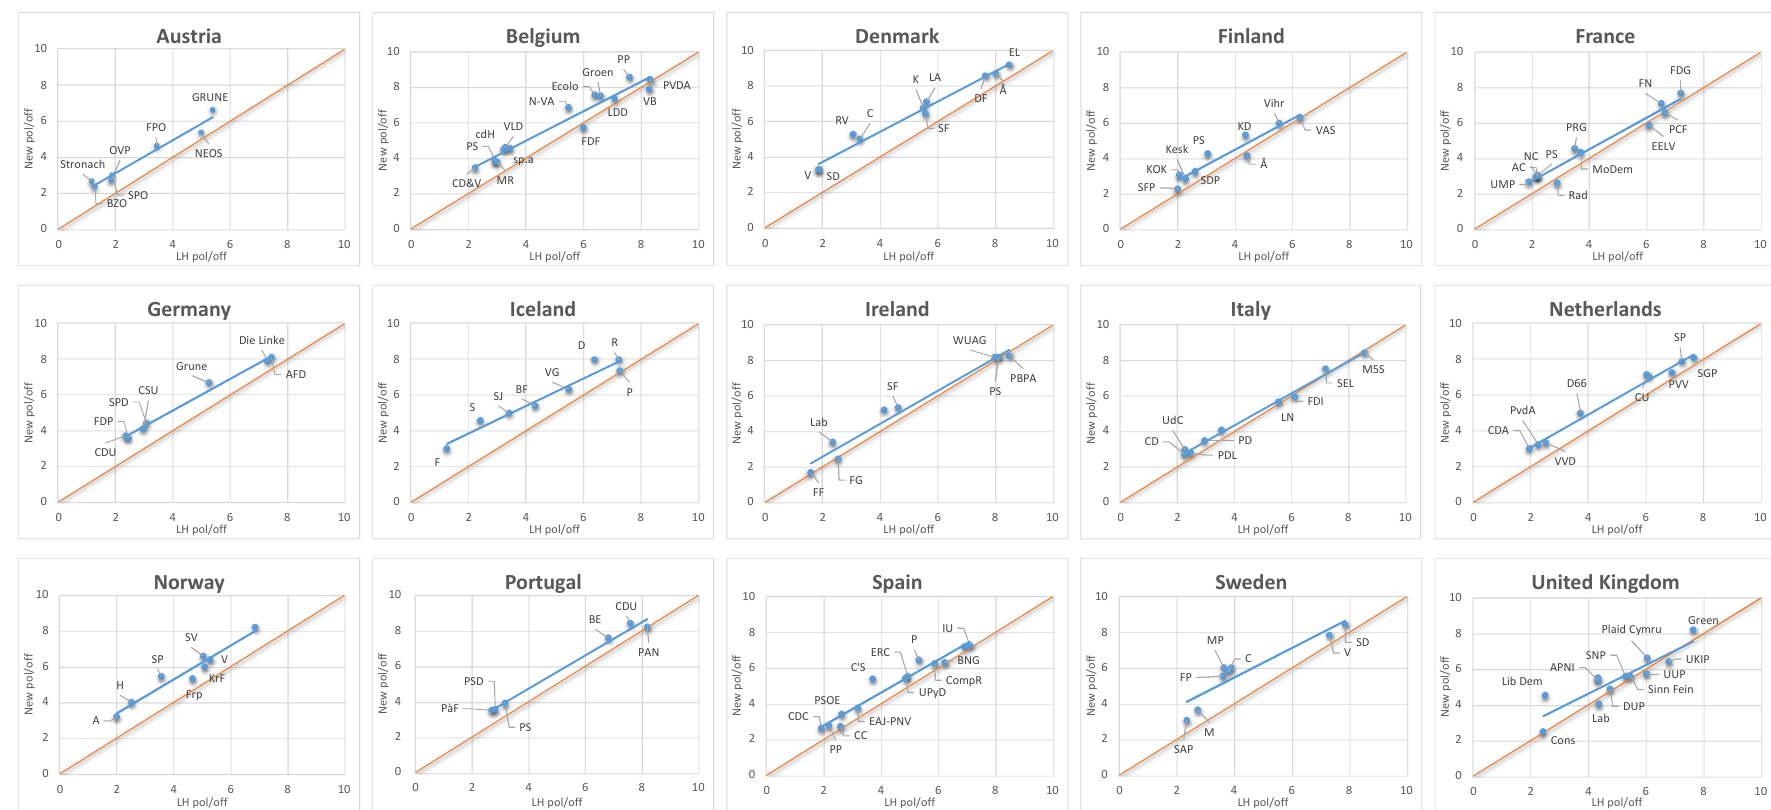
Figure 4. Parties’ policy-office preferences, by